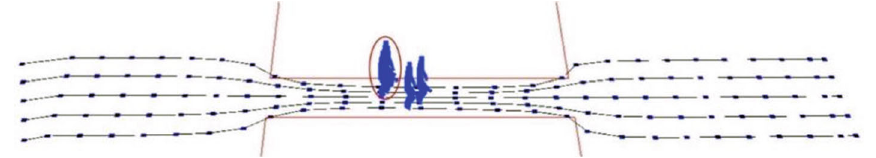
Figure 16: Collisions among people.